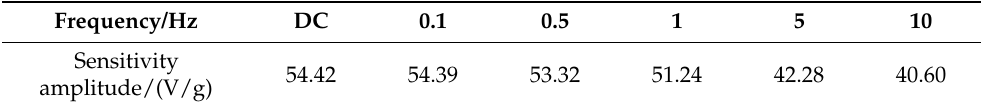
Figure 12. ( a ) Static sensitivity measurement using a high precision turntable ARMS150. ( b ) Dynamic sensitivity measurement using a low frequency vibrator APS129. Table 3. Sensitivity amplitude test results. (Two significant digits are taken for the results of the experiment).